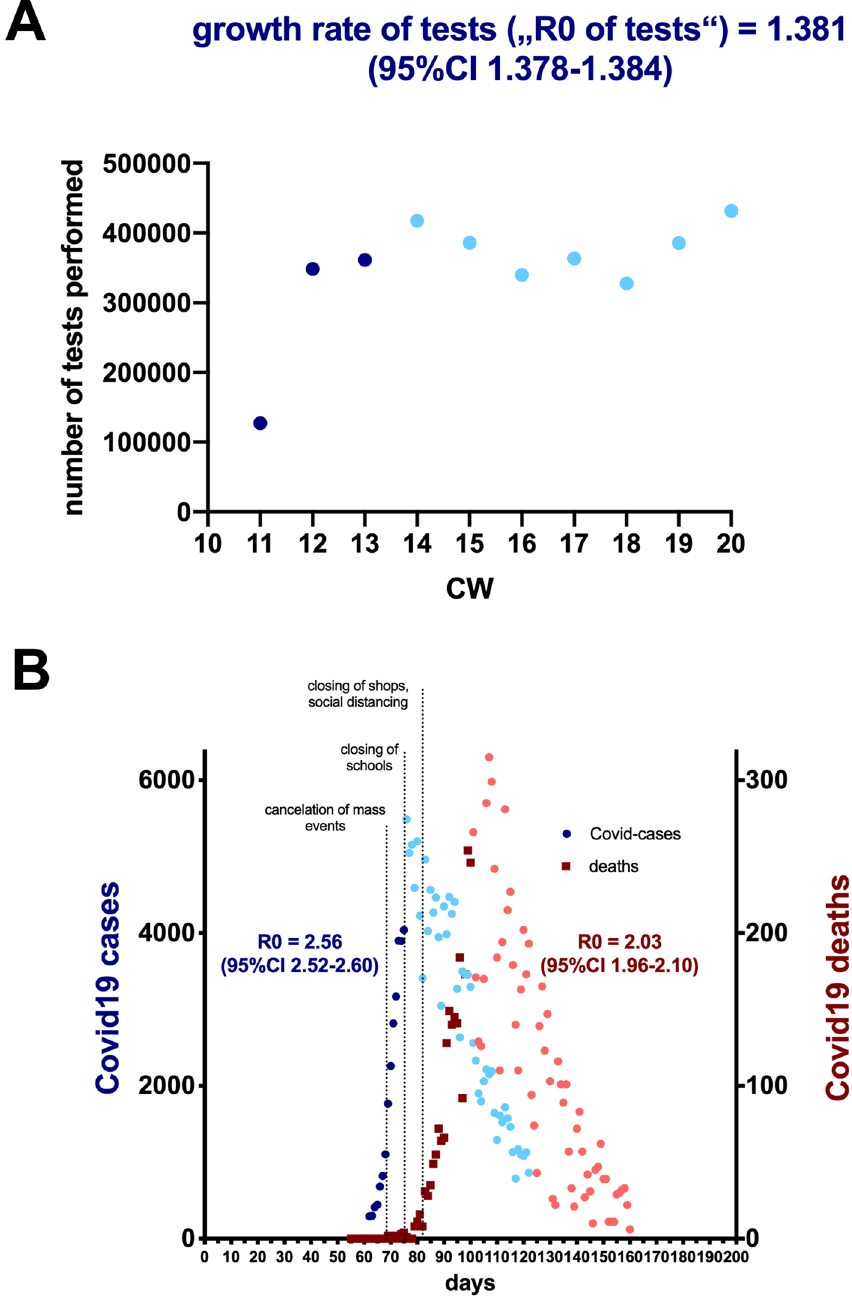
Figure 2. Calculation of R0 from Covid-19 disease incidence numbers and Covid-19 related deaths. ( A ) Data reported by the RKI for the number of performed SARA-CoV-2 RT-PCR-tests. ( B ) Data reported by the RKI for Covid-19-cases (blue symbols, left y-axis) and Covid-19 related deaths (red symbols, right y-axis). ( A,B ) Date were fitted to an exponential growth curve with a serial interval of 4.7 (± SD 2.9) to calculate R0. Dotted lines in B represent the dates for political interventions (03/09/2020 cancellation of mass events, 03/16/2020 closing of schools, 03/23/2020 closing of shops and social distancing). Dark blue and dark red symbols represent data points that were considered for the determination of R0, light blue and light red symbols represent later data points that were not considered for the